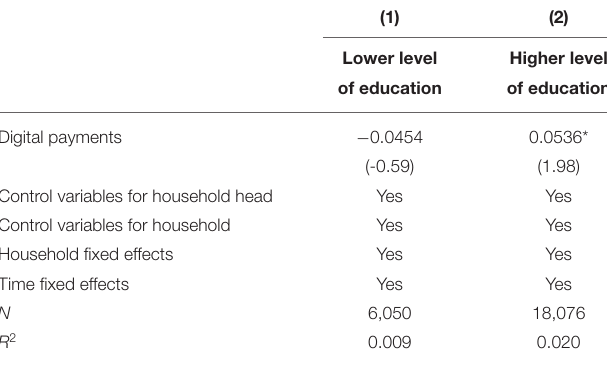
TABLE 11 | Heterogeneity in education level of household